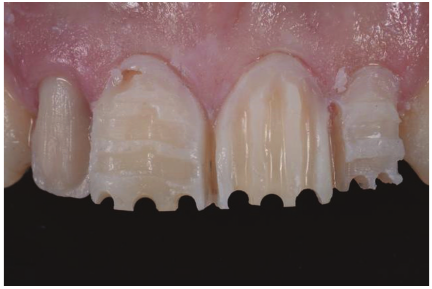
Figure 6: Mockup guide for teeth preparation.